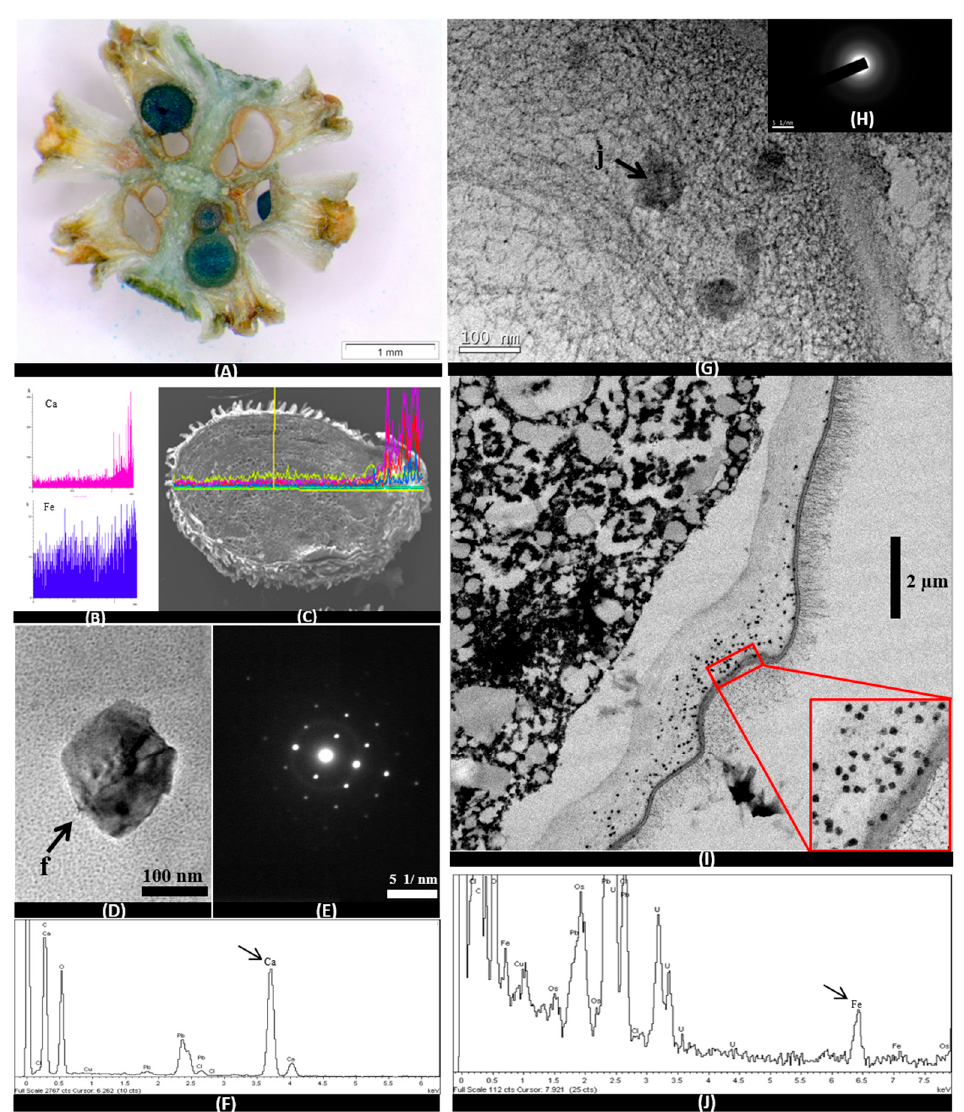
Figure 5. Images OM (A), SEM (C), TEM (D, E, G, H and I), SEM-EDX spectra (B) and TEM-EDX spectra (F and J) in embryos of S. pruinosa . ( A ) Cross section of floriferous stem with embryos completely dyed blue by Prussian Blue staining. ( B ) Representative Ca and Fe EDX spectra of embryo mapping in the longitudinal section of the seed. ( C ) Longitudinal section of the seed with the mapping from the spectra. ( D ) Crystal of Ca in cells of the radicle. ( E ) Electro diffraction pattern of calcium crystal. ( F ) EDX spectrum of the Ca crystal analyzed in part D of this figure. ( G ) Detail of nanometric particles of Fe at the edges of the embryo radicle. ( H ) Pattern of the Fe particles without diffraction. ( I ) Radicle edge with iron particles. ( J ) EDX spectrum of the Fe particles analyzed in part G of this figure.